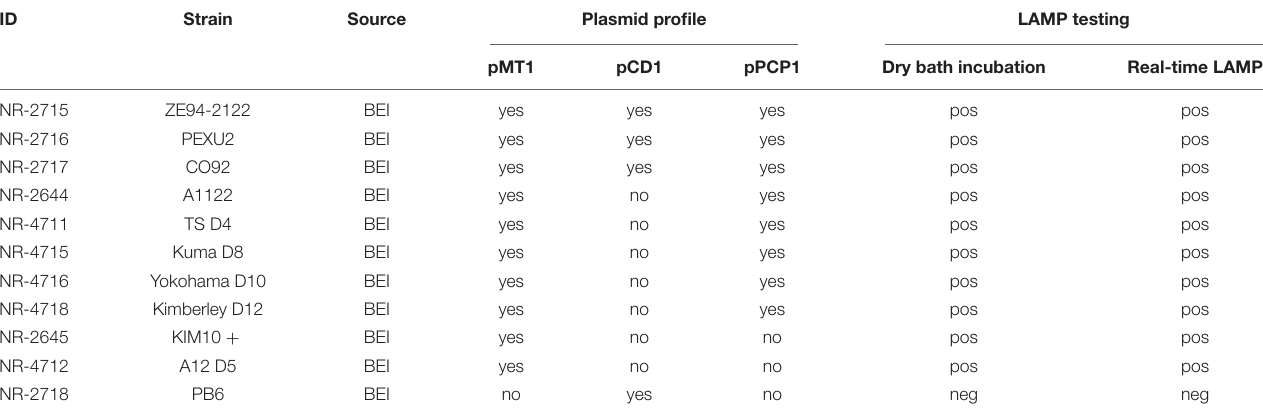
TABLE 2 | Loop-mediated isothermal amplification testing results for Y. pestis strains with different plasmid